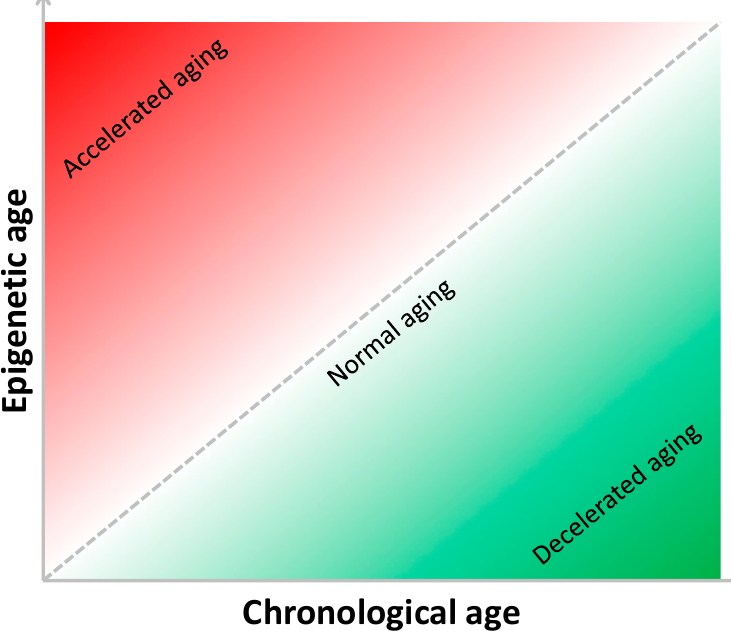
Figure 2. The relationship between chronological and epigenetic age.